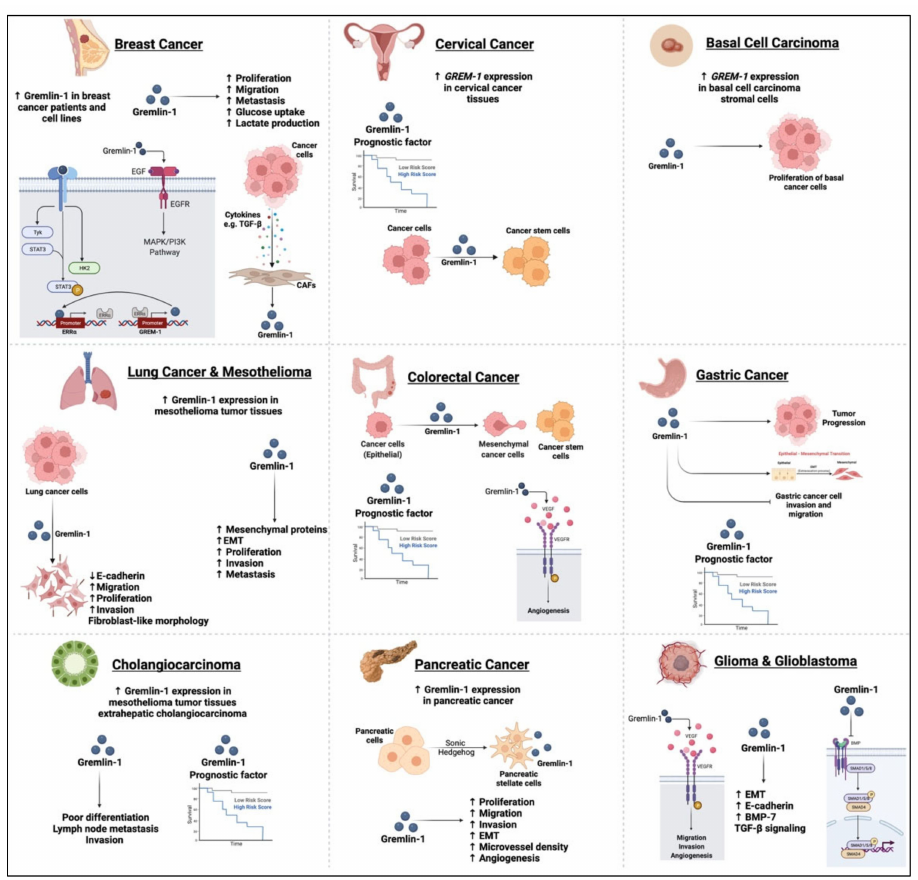
Figure 3. Role of Gremlin-1 in several cancer types including breast and cervical cancer, basal cell carcinoma, as well as lung, colon, gastric cancers, cholangiocarcinoma, pancreatic cancer and